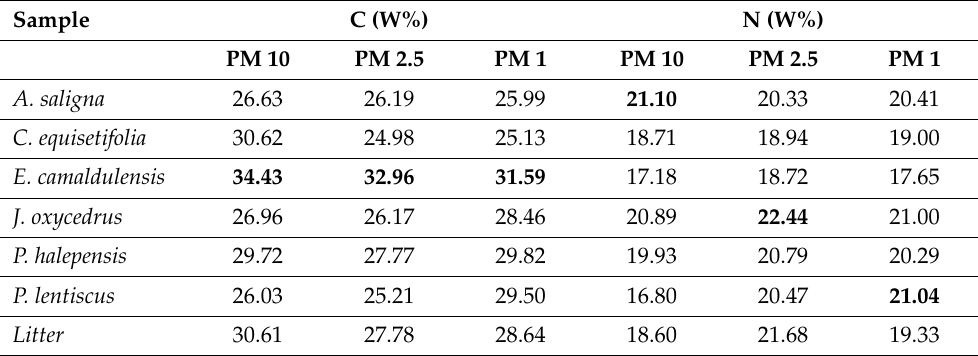
Table 1. The weighted volume percentages (W%) of carbon (C) and nitrogen (N) at the three main PM size fractions detected through scanning electron microscopy (SEM-EDX) on combustion filters. Maximum values are indicated in